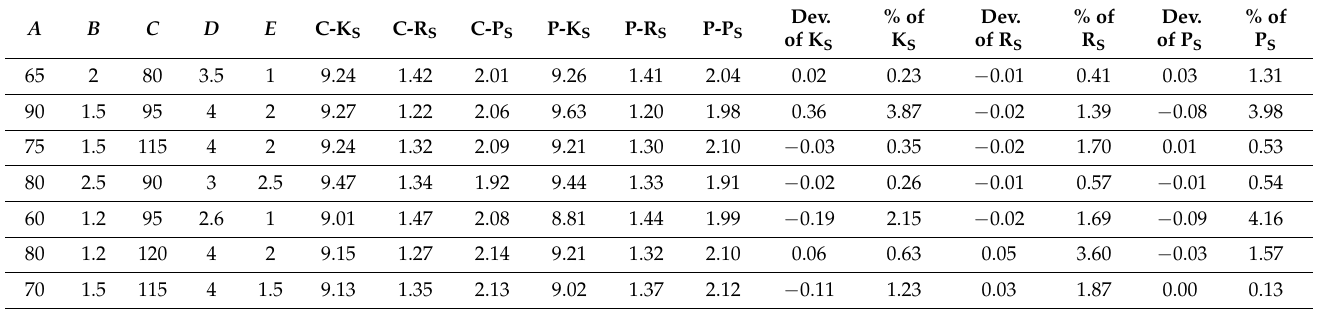
Table 12. Testing and comparing the prediction and calculation results for SMAW welding